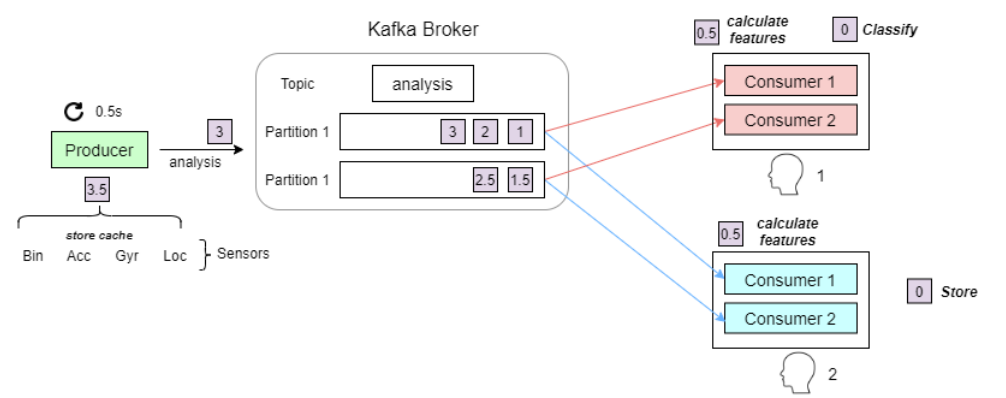
Figure 19. Kafka